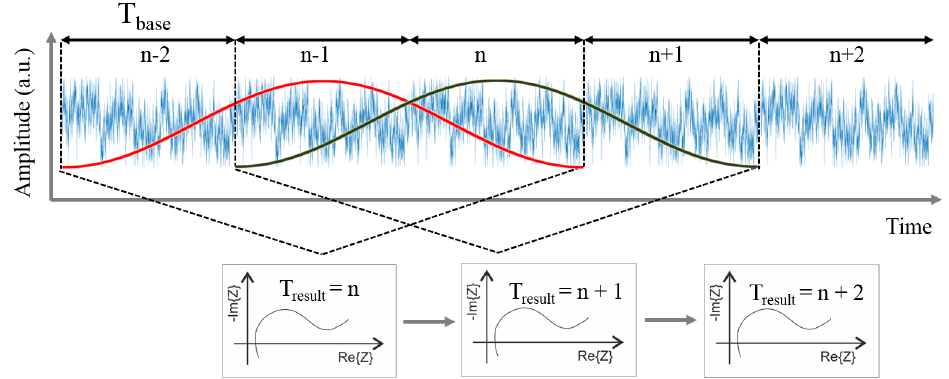
Figure 2. Schematic illustration of the used time-resolved Electrochemical Impedance Spectroscopy (EIS) technique (adapted from